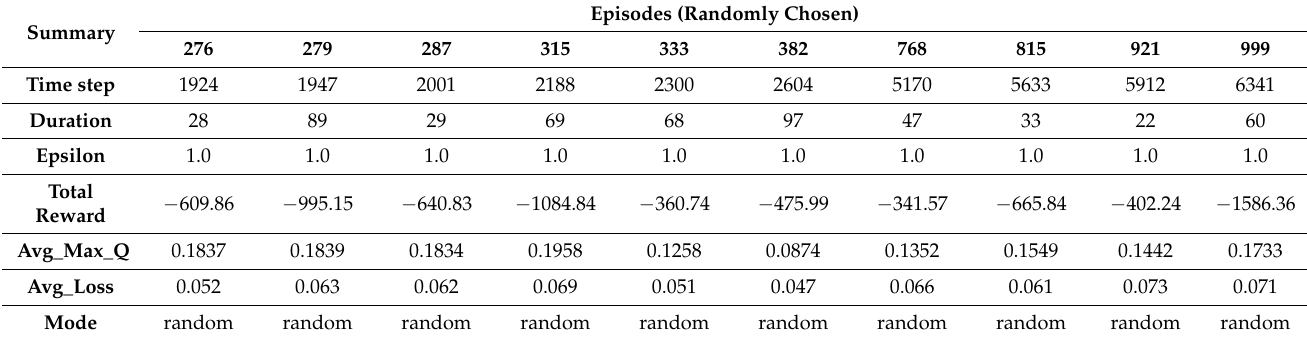
Table 2. Action-value based testing output of the DQN